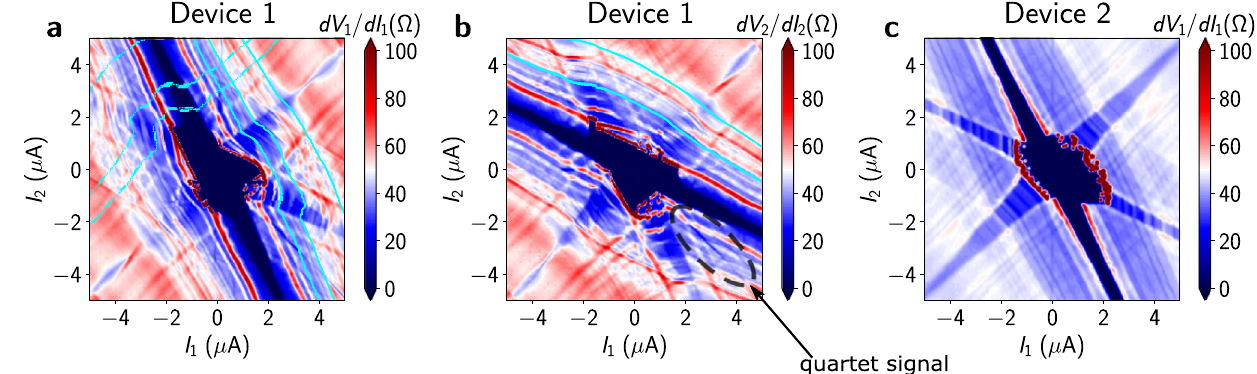
Fig. 2 | Three-terminal differential resistance maps. a Measurement of the dif- ferential resistance dV 1 / dI 1 on Device 1 with a small perpendicular magnetic fi eld. MARalongthe lines V 1 =2 Δ / n arehighlightedbycyanlinesandalong V 1 − V 2 =2 Δ / n highlighted by dashedcyanlines. b Measurement of dV 2 / dI 2 on Device1 with small perpendicular fi eld. MAR along V 2 =2 Δ / n are shown by cyan lines. The lower